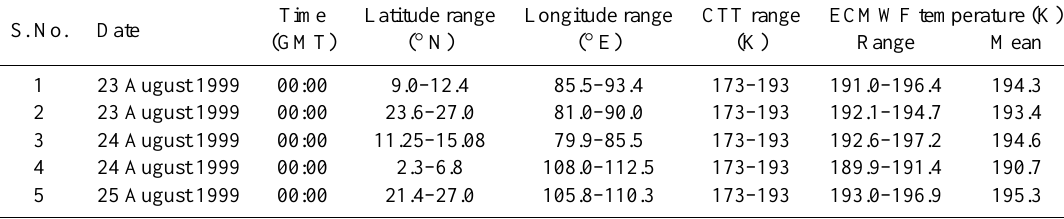
Table 2. Cloud top temperature (CTT) and ECMWF reanalysis temperature over the region of cloud with cold CTT. S.